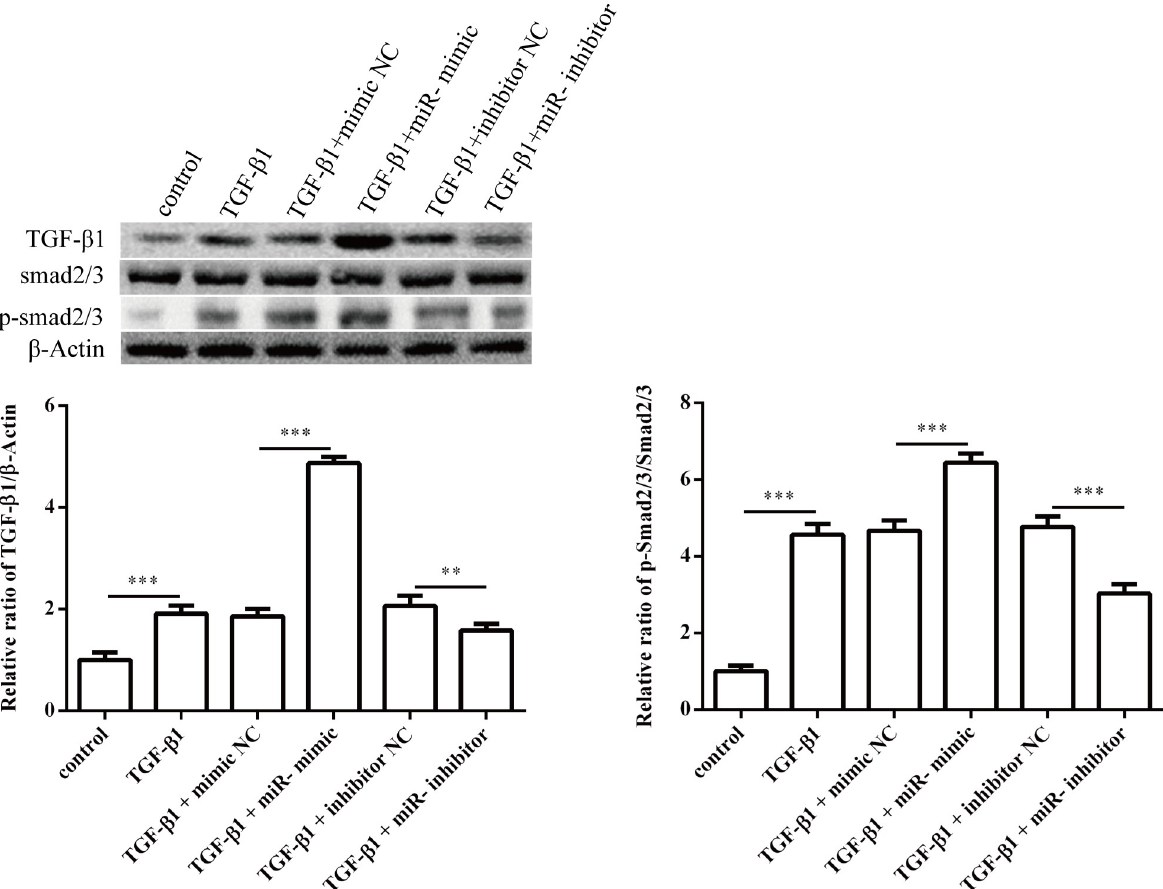
Fig 5. Effects of miR-1202 on the TGF- β 1/Smad2/3 pathway. All of the data are shown as the mean ± SD. Compared with the control group. n = 3, � P < 0.05; �� P < 0.01; ��� P < 0.001. The analysis is not able to detect small significant differences due to small sample size.